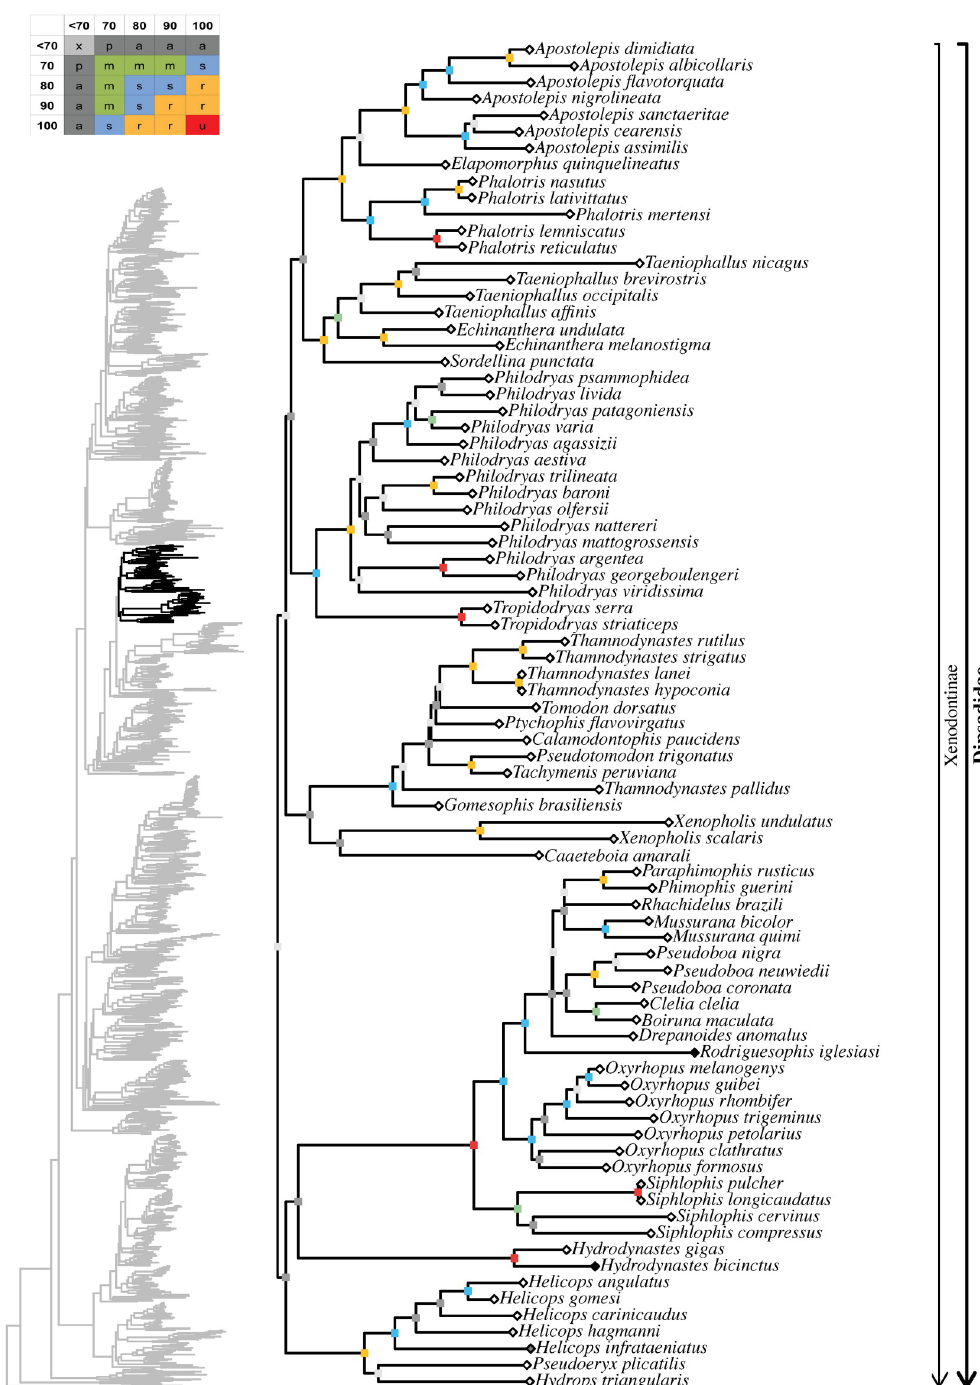
Fig 17. Maximum likelihood species-level phylogeny of Colubroides (continued). Family Dipsadidae (continued).